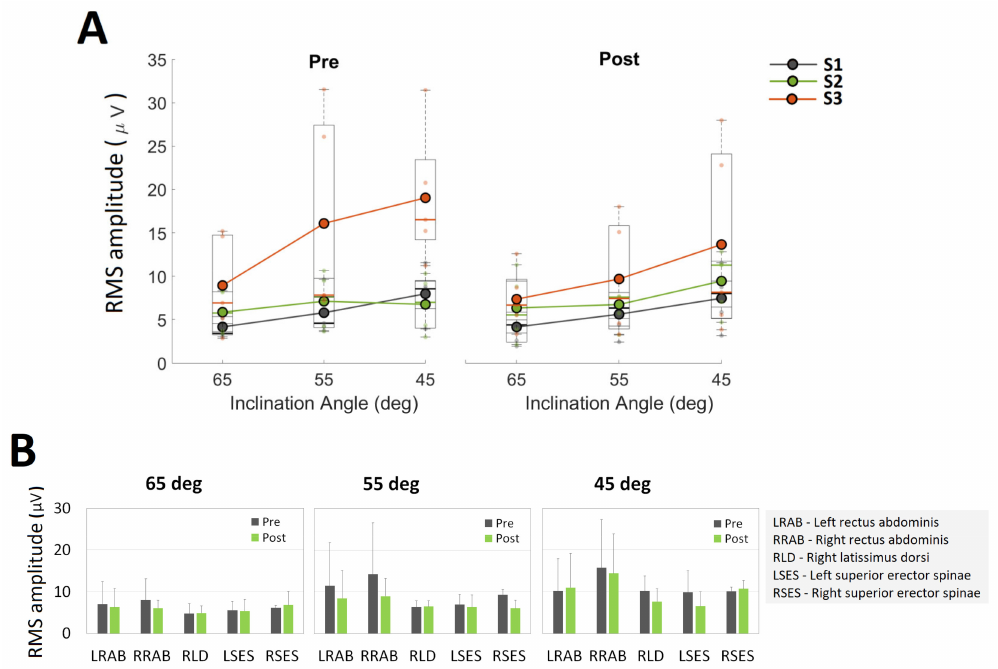
Figure 3. ( A ) Box plot representation of electromyography (EMG) data for all three participants. EMG data from all channels are consolidated into a single dataset for each IA for every participant, ( B ) the mean EMG root-mean-squared (RMS) amplitude for all participants for each muscle group at each IA, before and after the intervention. Error bars represent the standard